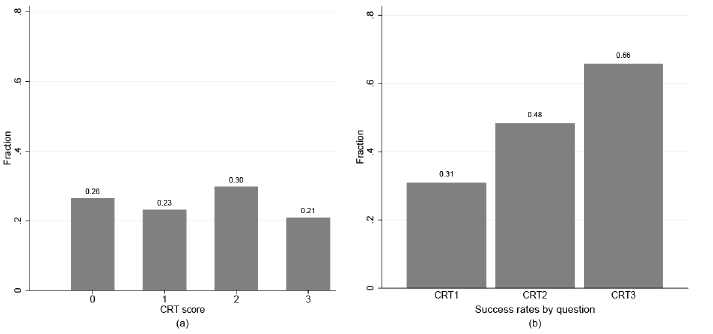
Fig 1. Subjects ’ performance in the cognition reflection test.